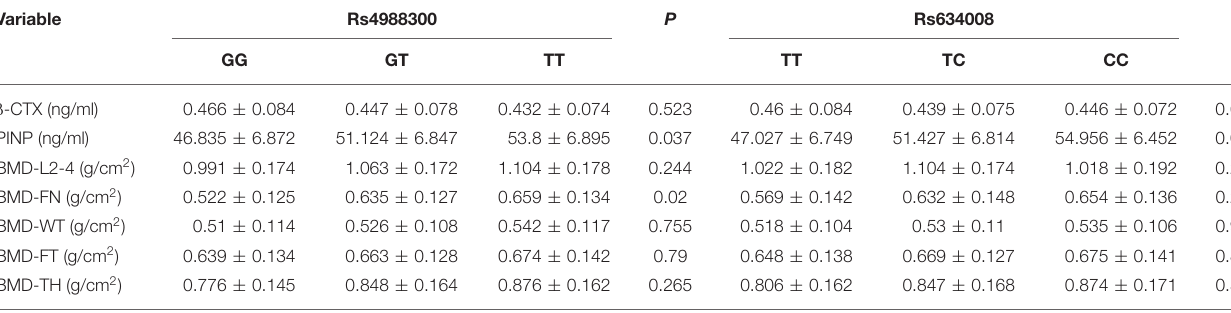
TABLE 5 | Relationships of SNPs genotyped with BTMs and BMDs in male with OP. Variable